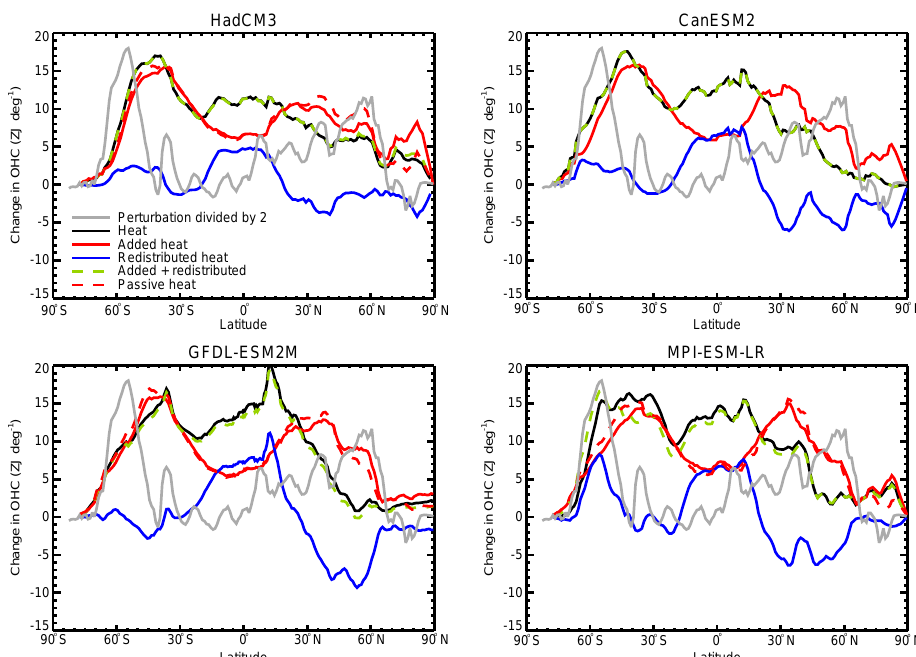
Figure 10. Change in ocean heat content (10 21 J per degree of latitude) relative to the control in the time mean of the final decade of the faf- heat and faf-passiveheat experiments. The changes in ocean heat content, added heat and redistributed heat are calculated from the integrals over longitude and depth of θ , T A and T R respectively, multiplied by volumetric heat capacity. The surface heat flux perturbation F is shown as its integral over longitude and time (for 65 years, to the middle of the final decade), divided by 2 in order to fit on the same axis. The global integrals of F and T A should be equal.